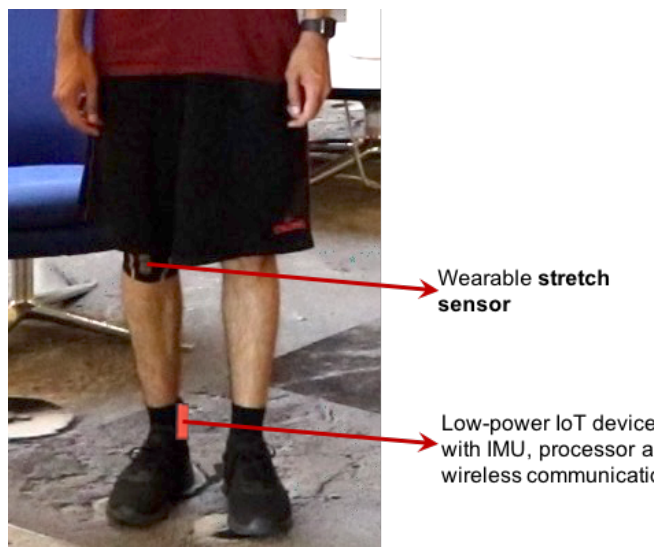
Figure 1. Overview of the wearable setup used for data